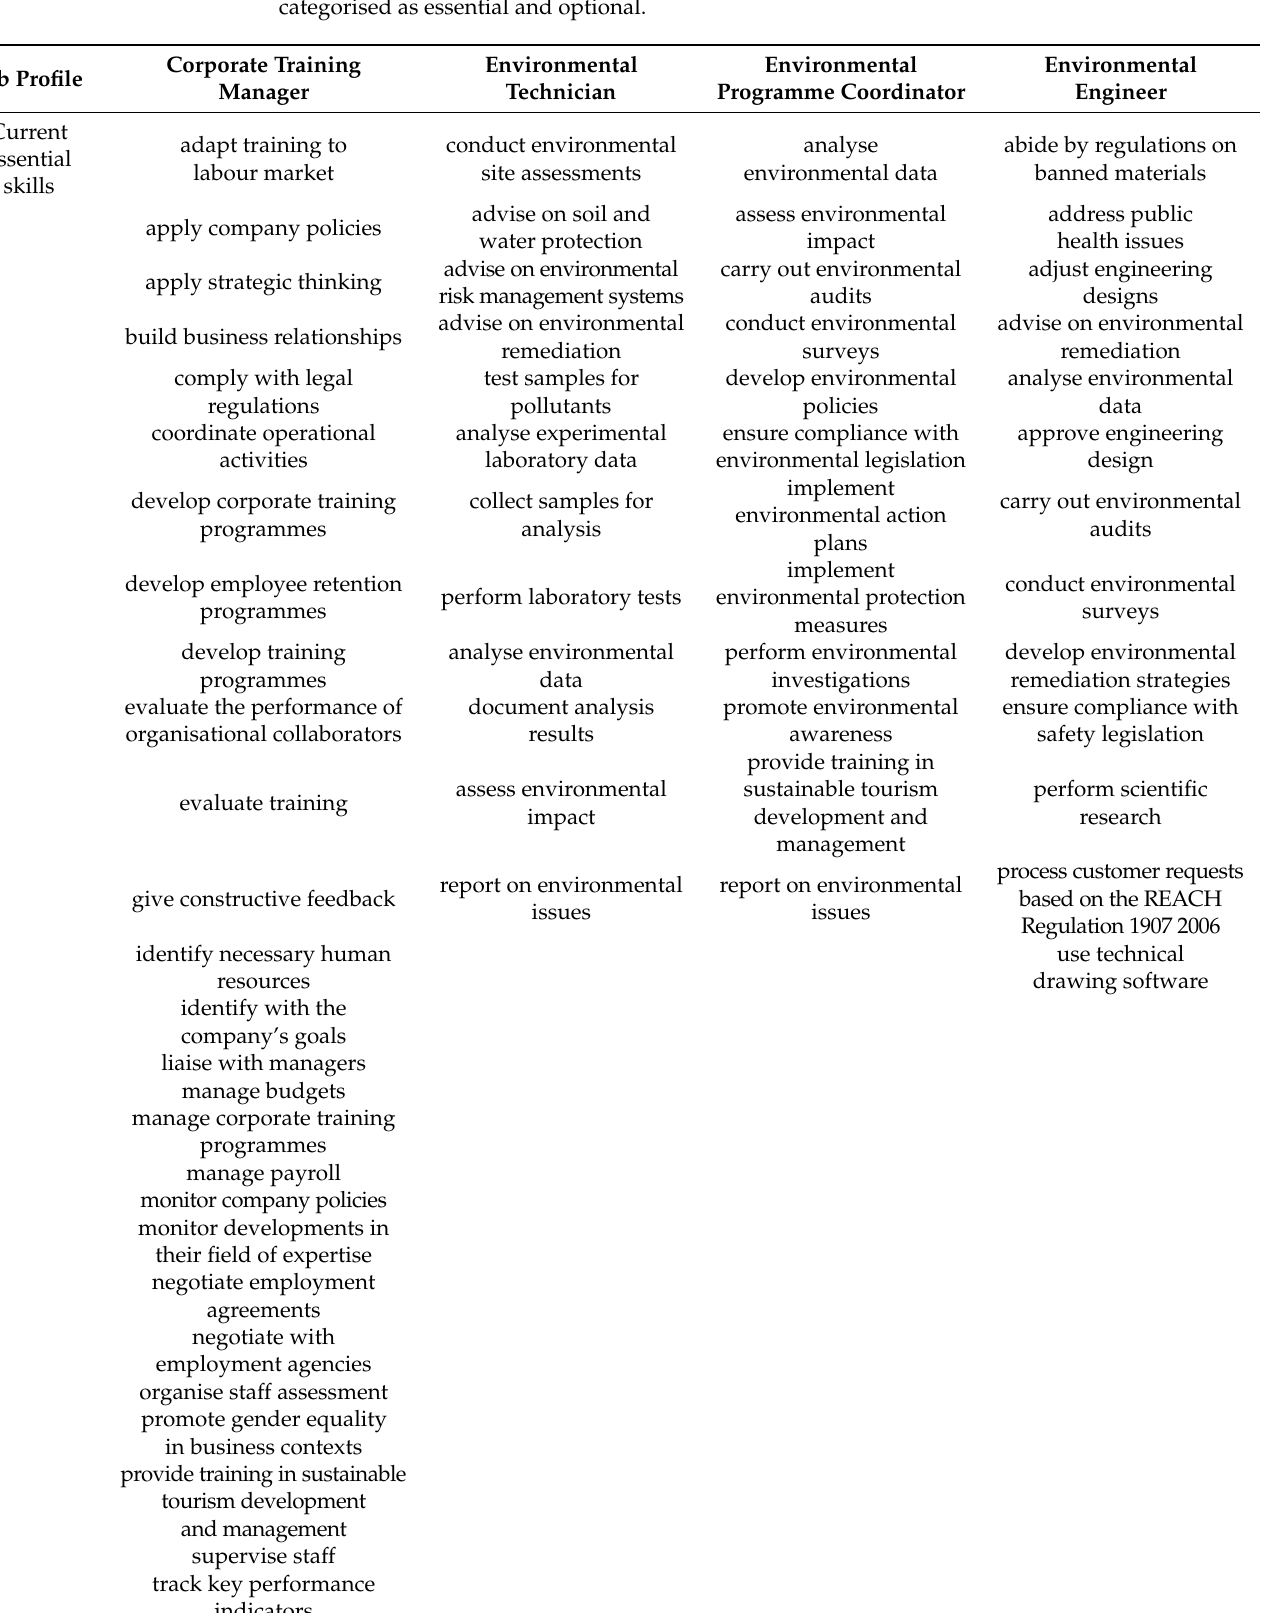
Table 4. An overview of the generated database: current skills needs of the selected job profiles, categorised as essential and